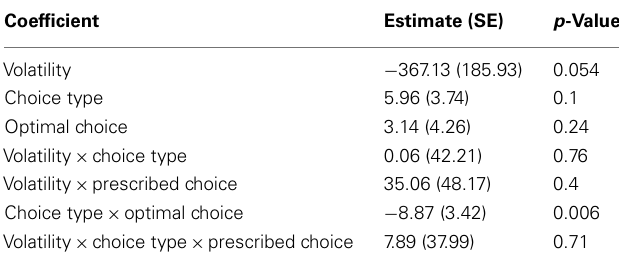
Table 2 | Choice latency regression coefficients.